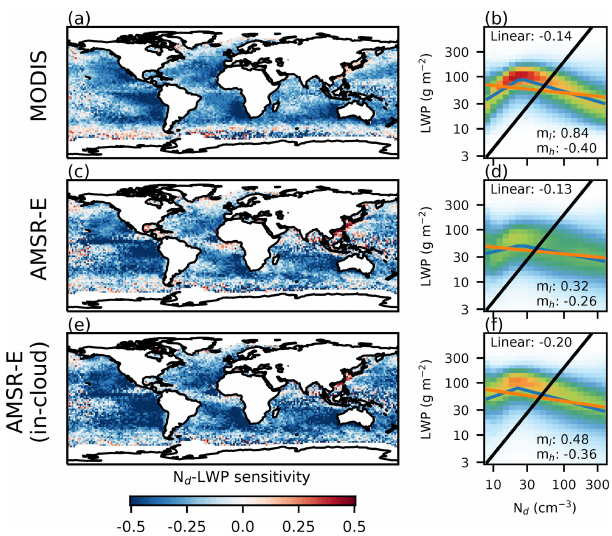
Figure 2. (a, c, e) The sensitivity (linear regression coefficient in log–log space) of N d to LWP for a selection of different LWP mea- sures, using MODIS N d for the period 2007–2009. The sensitivities are calculated at a 1 ◦ by 1 ◦ resolution from instantaneous (daily) data. (a) MODIS LWP, (b) AMSR-E (all-sky) LWP and (c) AMSR- E (in-cloud) LWP. The right-hand column shows the global joint N d –LWP histogram, where each column is normalised so that it sums to 1 (showing P( LWP | N d ) ). The black line is at an effective radius of 15µm (assuming adiabatic clouds), an approximate indi- cator of precipitation, with precipitating clouds lying to the upper left of the line. The orange line is a linear regression on the data, with the linear sensitivity shown in the top left of the subplot. The blue line is a fit of the form Eq. (1), with the gradients m l and m h shown in the lower right of each